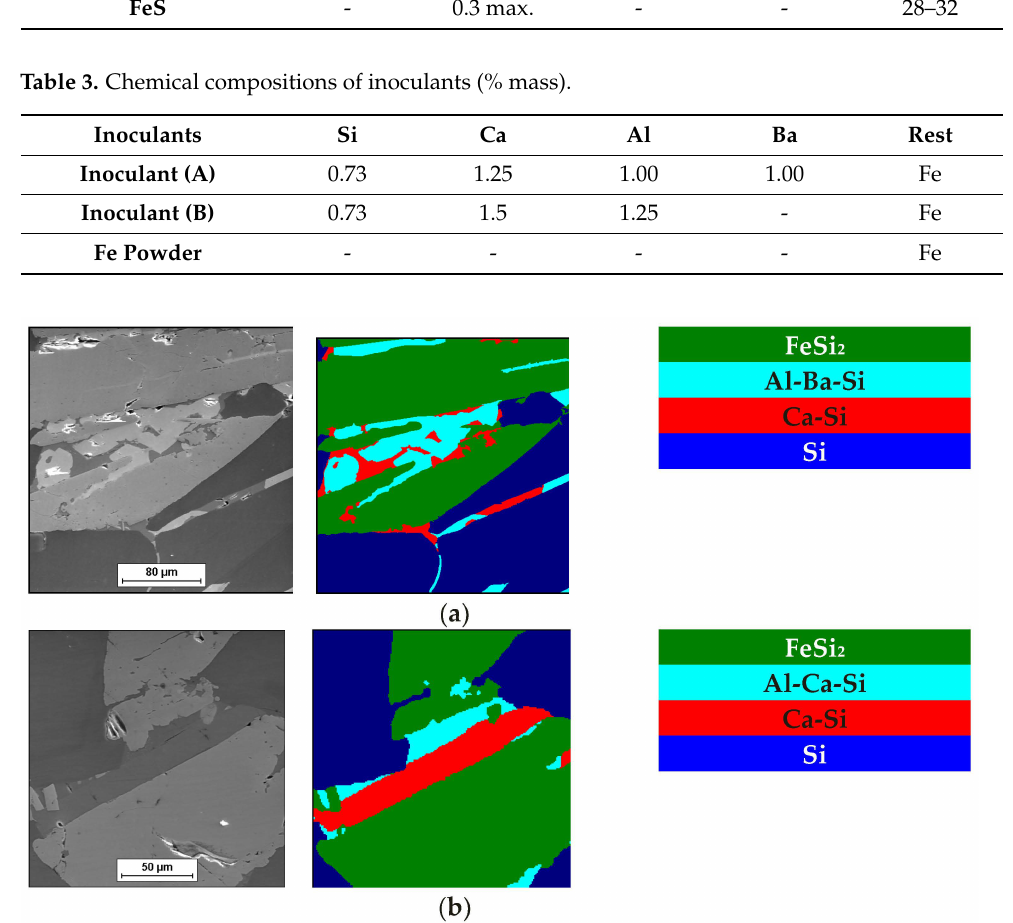
Figure 4. Distribution of main phases that were present in inoculants: ( a ) Type (A)— (FeSi 2 +Al-Ba-Si+Ca-Si+Si); ( b ) Type (B)—(FeSi 2